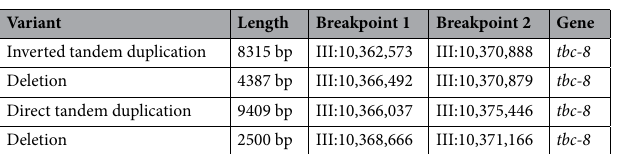
Table 2. Complex rearrangement breakpoints in VC109 on